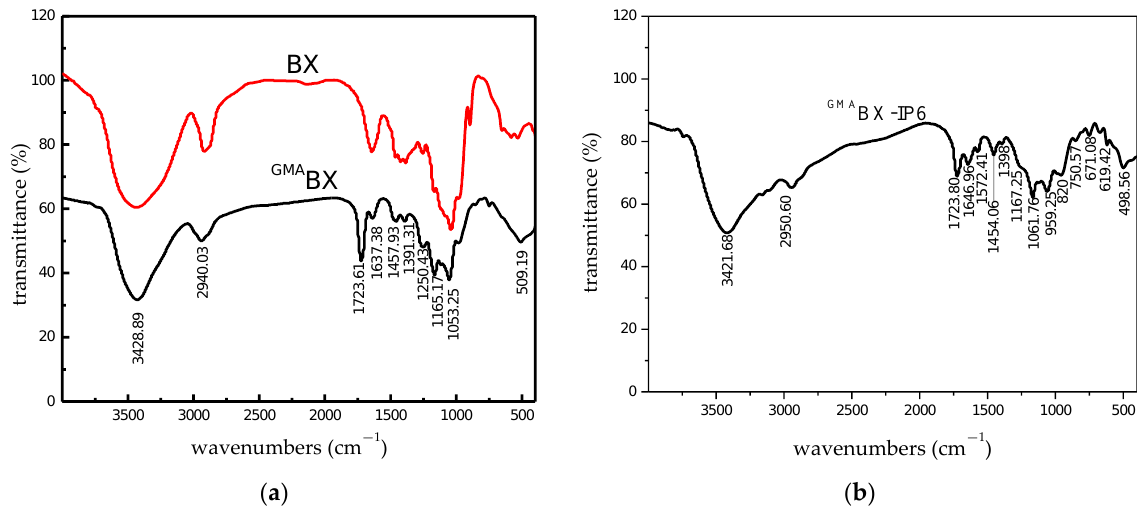
Figure 4. FTIR spectra of BX, GMA BX and GMA BX-PA. ( a ) FTIR spectra of BX and GMA BX. ( b ) FTIR spectra of GMA BX-PA.